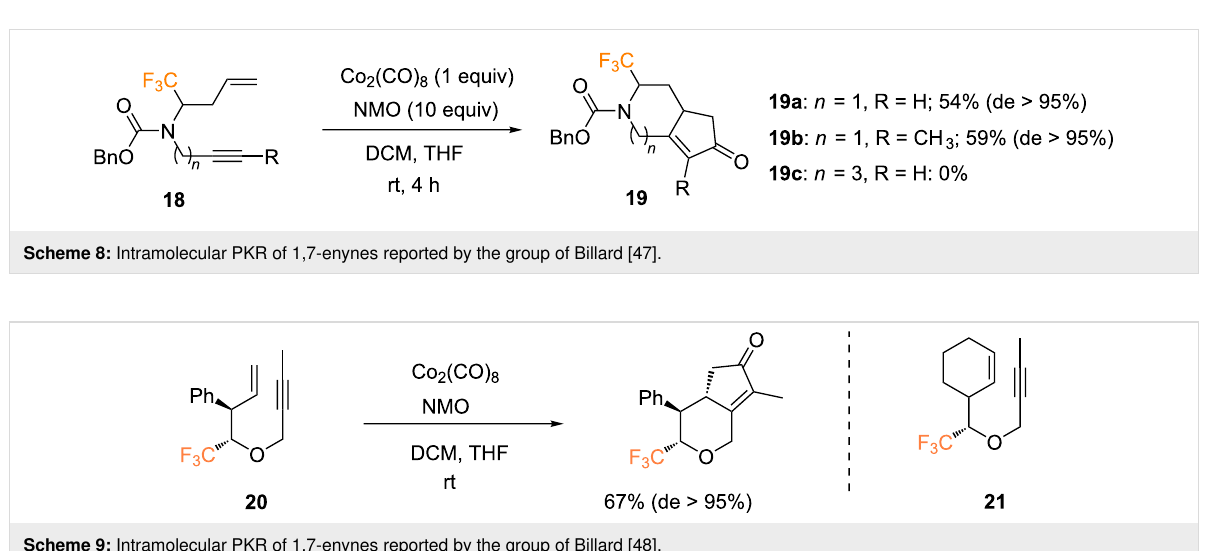
Secondly, PKR with enynes 14 containing fluorinated propargyl alcohol groups yielded diastereoisomeric mixtures of pyrrol- idine ring-fused cyclopentenones 15 in good yields